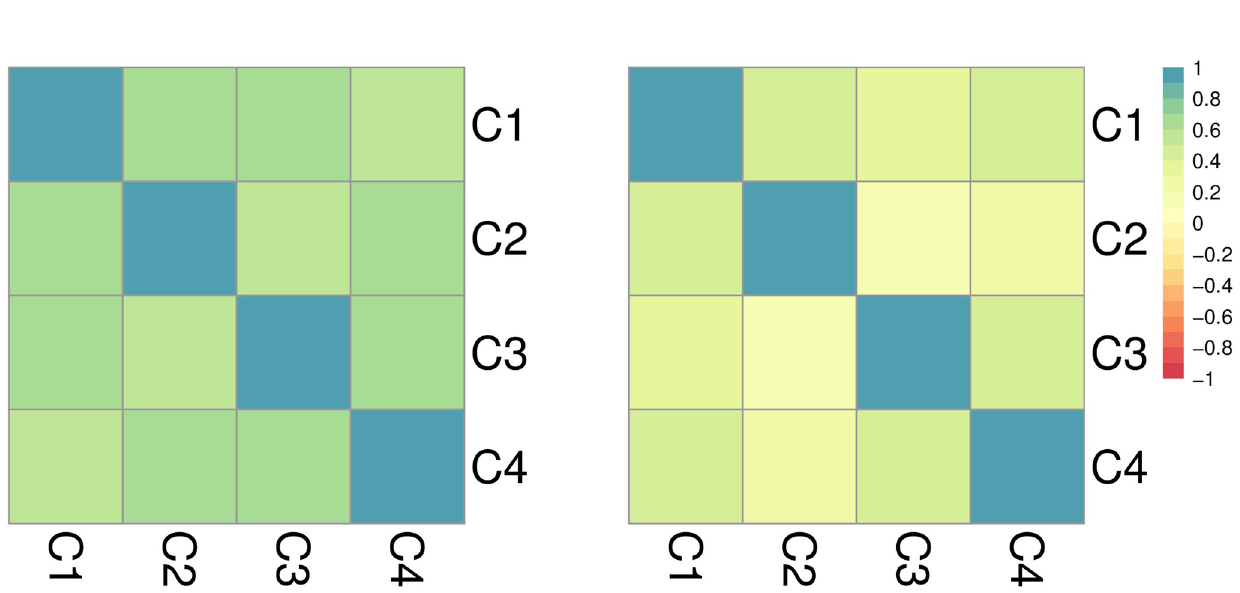
Fig 6. Cluster dynamics in India: (left) Pearson’s correlation of weekly events n j across pairs of clusters. (right) Pearson’s correlation of differentiated = n . The color scale is restricted to positive values as as no negative relationships are found. The left panel reveals a substantial level weekly events Δ n j j − n j − 1 of correlation, however, when first-order differences are considered all coefficients decrease, implying that the rate of change in the occurrence of events is less